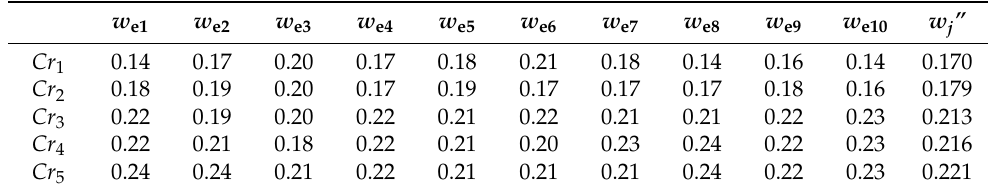
Table 15. Individual and group criteria weights calculated by applying the PIPRECIA method.